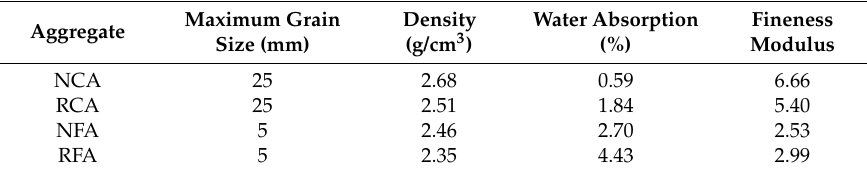
Table 1. Physical characteristics of aggregate used in this study.